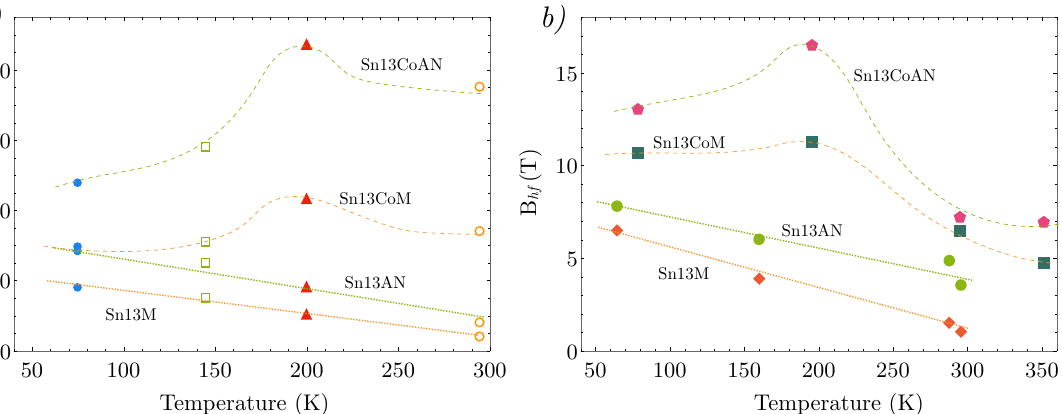
Figure 5. The temperature evolution of the M s ( a ) and B hf ( b ) of the milled and annealed Ni 50 Mn 37 Sn 13 and Ni 45 Mn 38 Sn 13 Co 4 samples. The lines are a guide to the